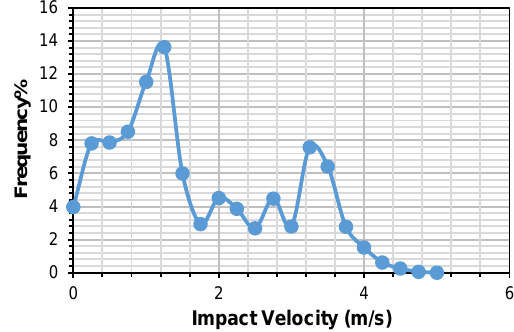
Fig. 6. Distribution of impact velocities for 425-500 μm particle against inner ring at 3000